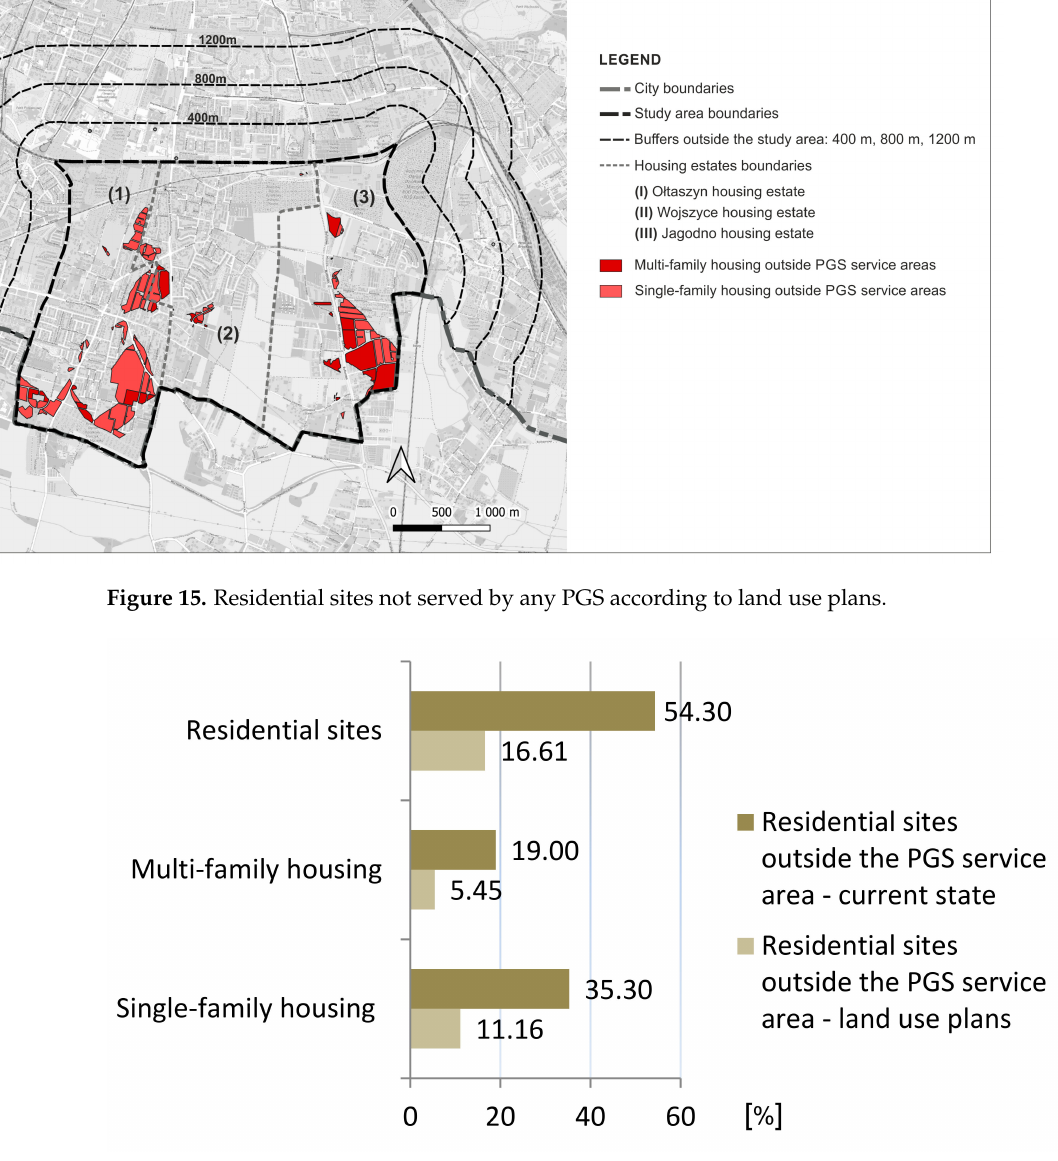
Figure 16. Residential sites not served by any PGS, comparison of the current state and land use